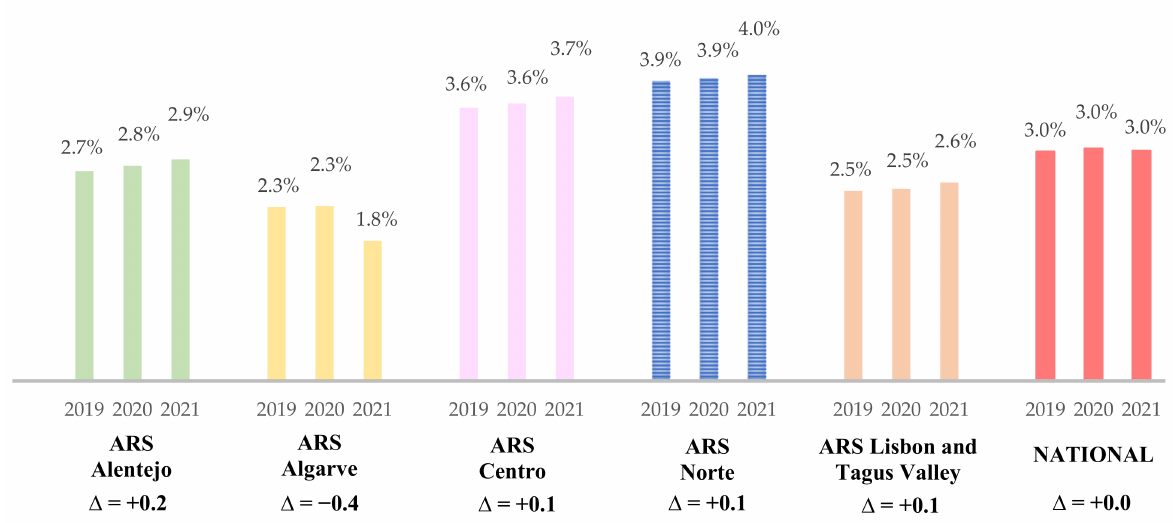
Figure 1. Total benzodiazepine prescription share (%) in older adults at a National Level and by ARS, from 2019 to 2021. Variance level ( ∆ ) presented. ARS—Portugal’s Regional Health Administrations (ARS—Administraç ã o Regional de Sa ú de).